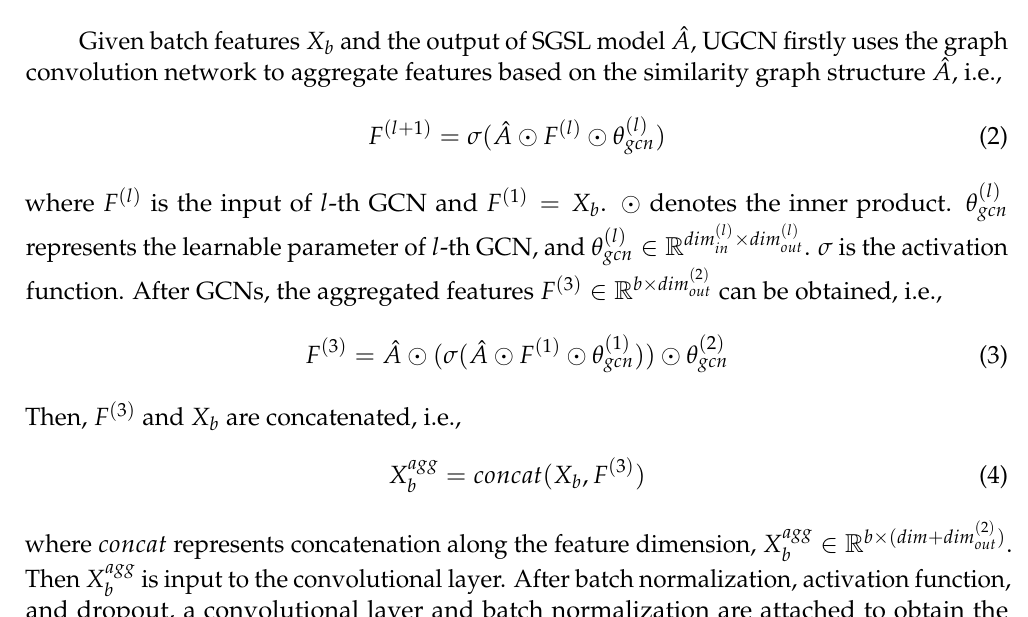
Figure 3. The architecture of the proposed UGCN. Similarity graph structure ˆ A and batch features X b are input to UGCN. After the two-layer GCN, features with neighbor aggregation F ( 3 ) are obtained. Then, F ( 3 ) and X b are concatenated and input to the classifier. “Conv” represents the convolutional layer, “BN” is batch normalization, and “DP” denotes